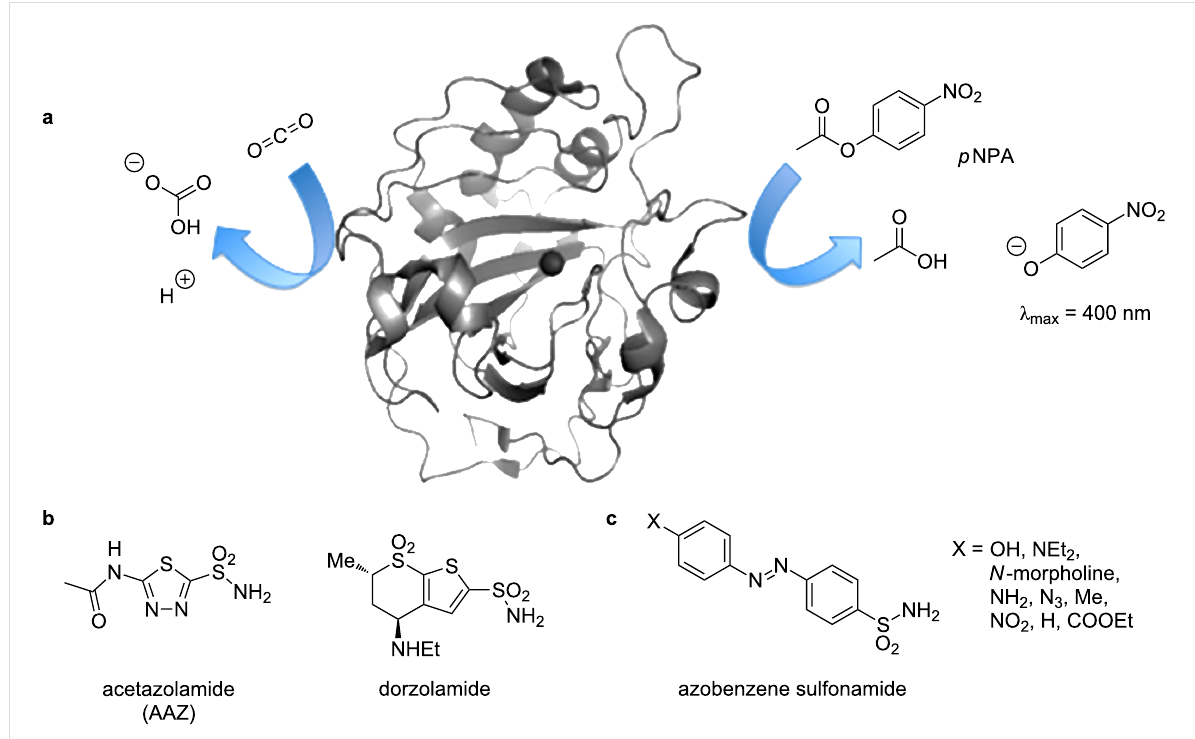
Figure 1: Function and inhibition of hCAII. a) hCAII (pdb: 2vva [7]) catalyzes the hydration of carbon dioxide to bicarbonate and a proton (left) as well as the hydrolysis of p NPA to acetate and a colored phenolate ( λ max = 400 nm). b) Aryl sulfonamide-containing pharmacophores of hCAII. c) Aryl sulfonamide merged to